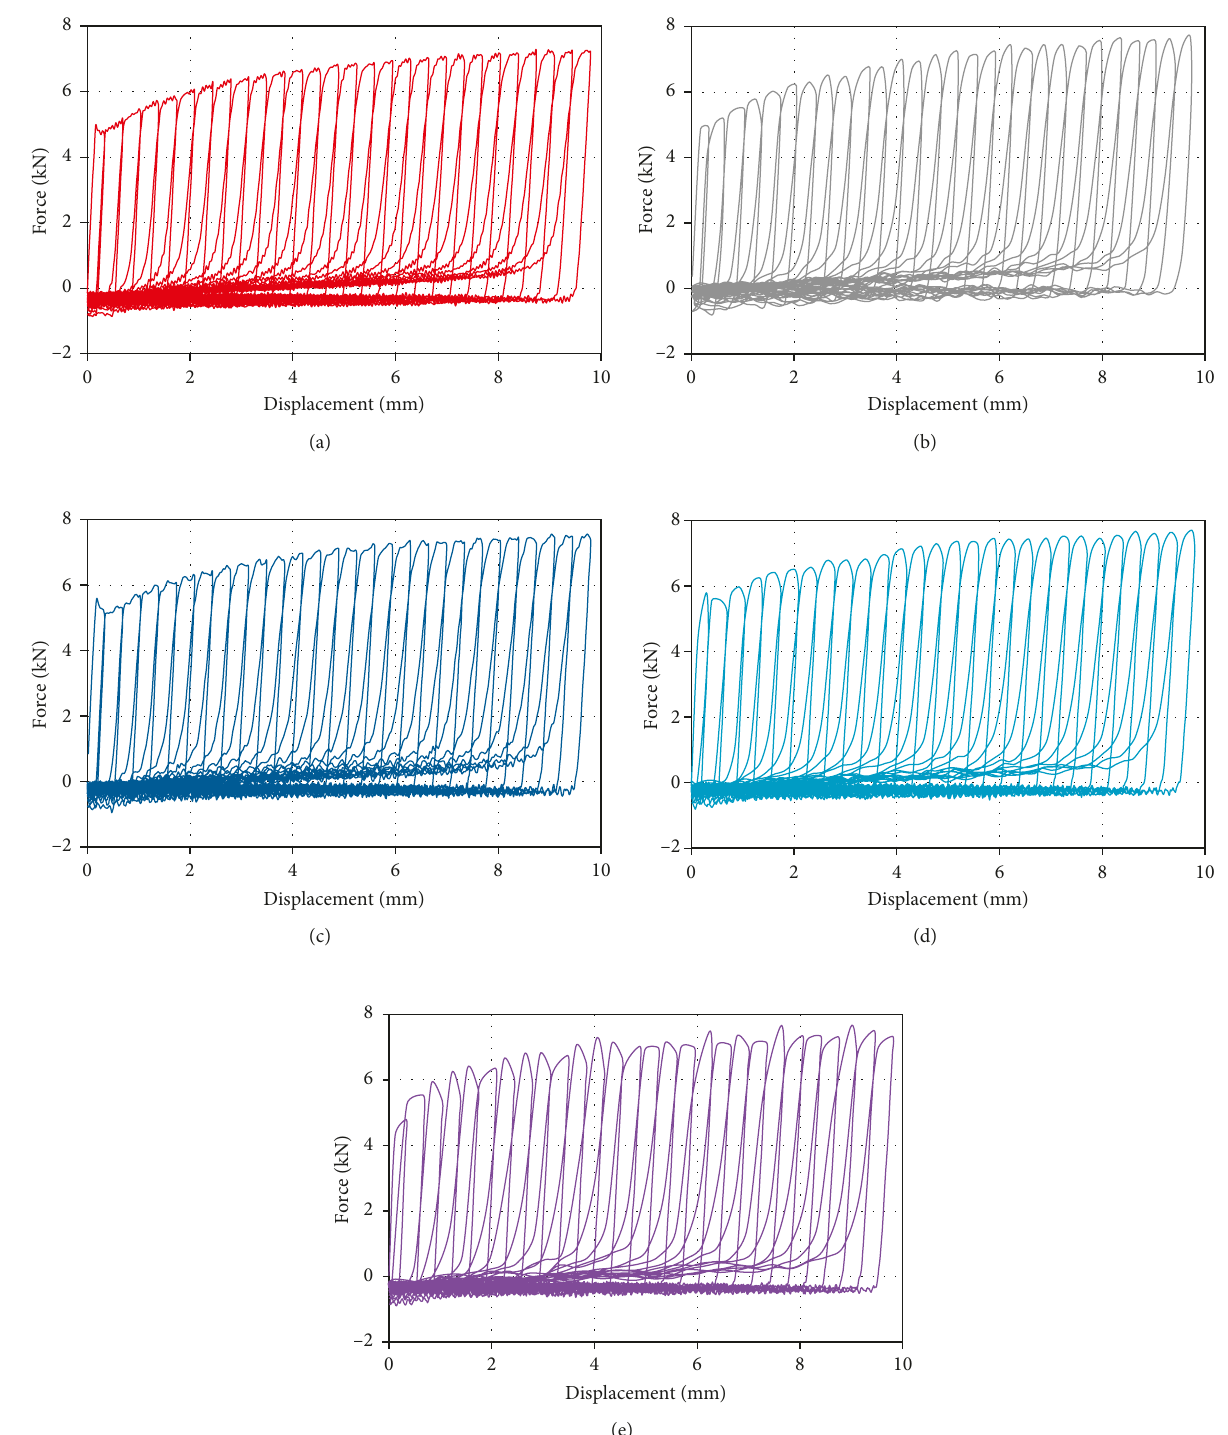
Figure 20: Force and displacement curves for steel materials subjected to different loading speeds. (a) Steel-1 (0.033 mm/sec). (b) Steel-2 (0.165mm/sec). (c) Steel-3 (0.330 mm/sec). (c) Steel-4 (1.650mm/sec). (e) Steel-5 (3.300